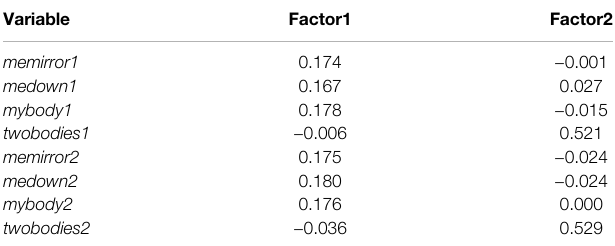
TABLE 3 | Scoring coef fi cients for the principal components factor analysis of the questionnaire scores of exposures 1 and 2. (Method (cid:2) regression based on varimax rotated